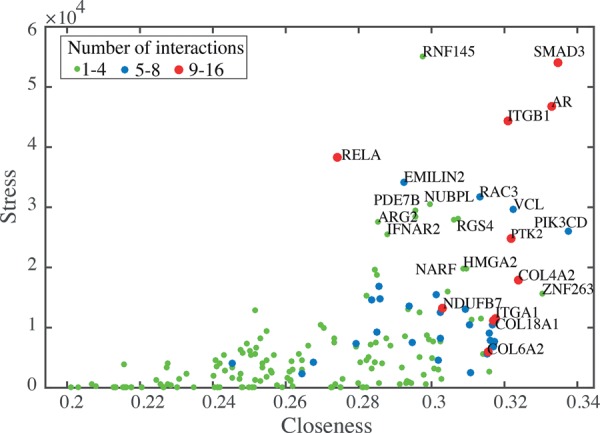
Analysis of the shape-gene network. A plot of the properties of gene nodes summarizing degree, closeness, and stress. Protein names for nodes that have high values for any of these features are shown.